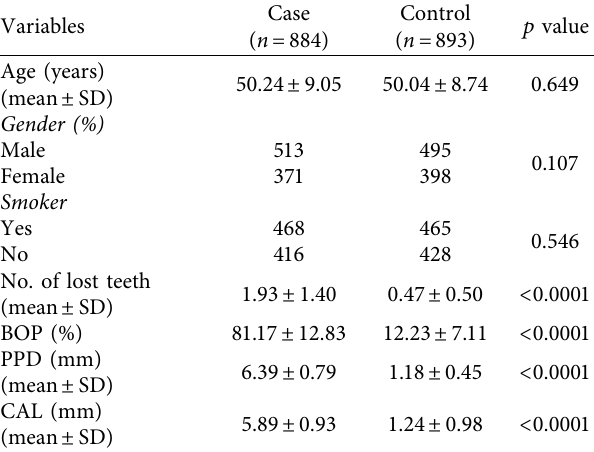
Table 1: Demographic and clinical characteristics of the cases and